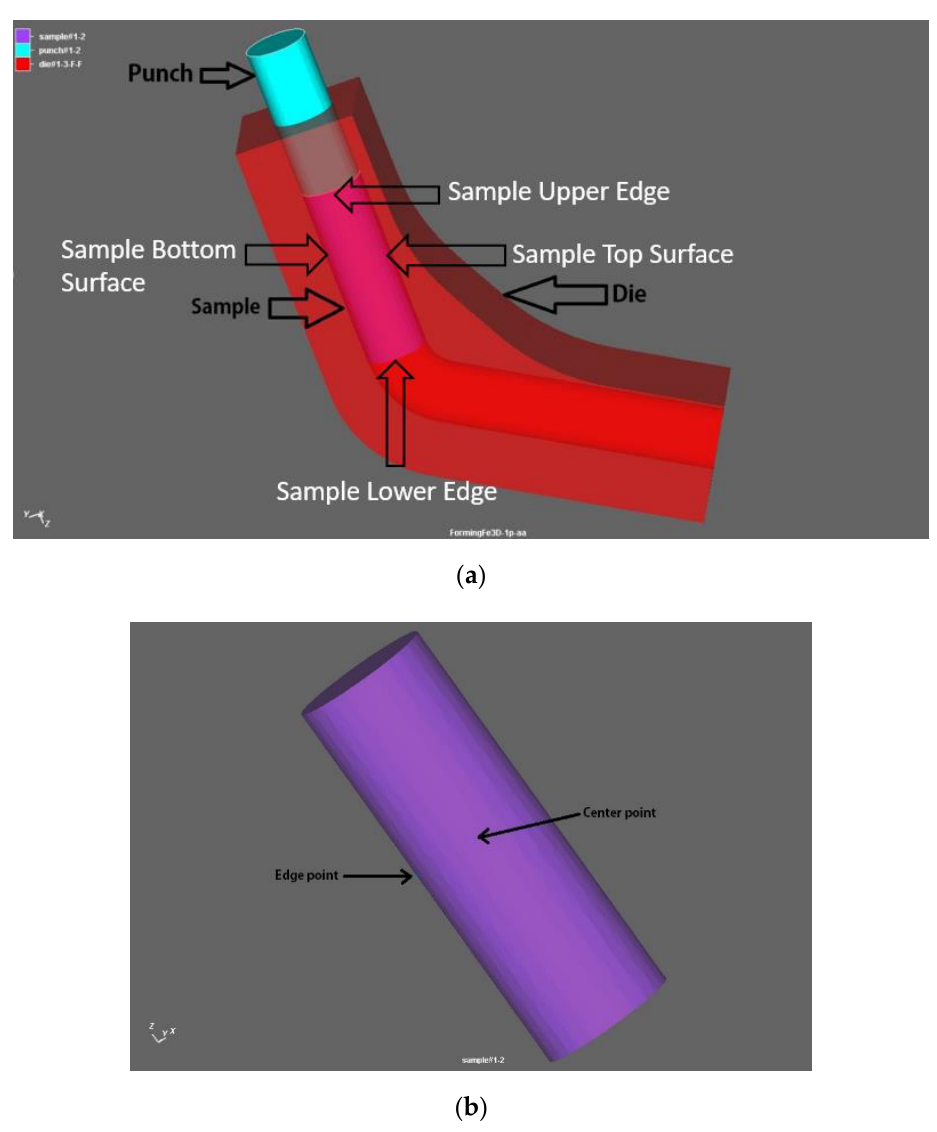
Figure 3. The ECAP die, punch, and sample used in FE simulation ( a ), Tracked elements located at the plane in the middle of the specimen at the sample’s edge and at the center ( b ).